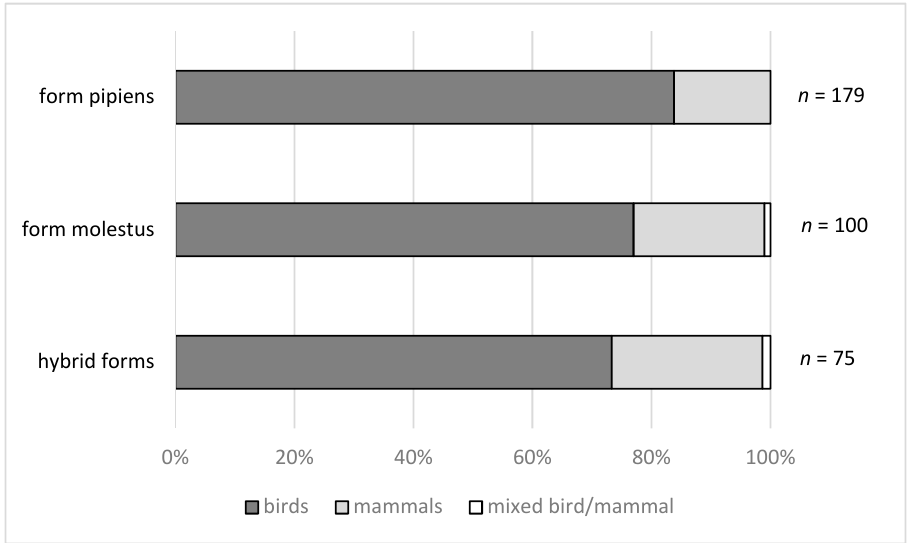
Figure 4. Proportion of blood meals of Culex pipiens taken from birds, mammals or mixed bird/mammal sources. Data collated from [117,147,149].